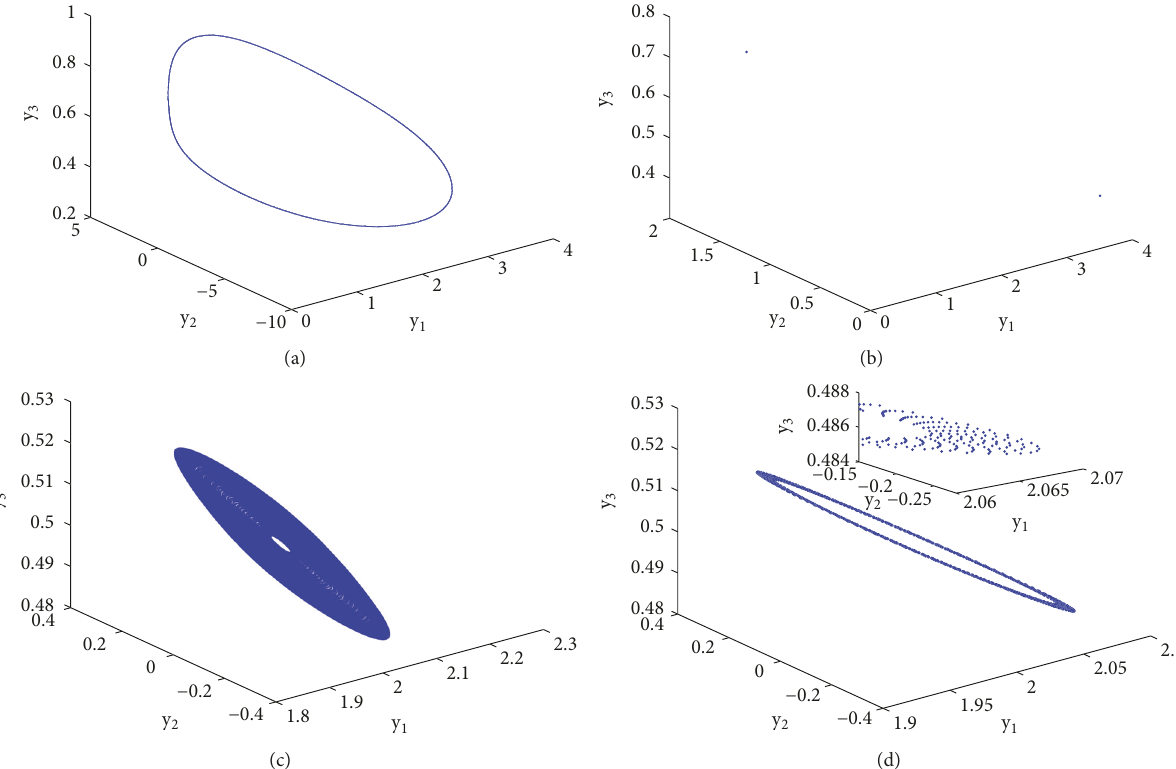
Figure 9: Phase portraits ((a), (c)) and Poincar´e sections ((b), (d)) for solutions in Figures 7(c) and 7(d); (a) and (b) for the solution in Figure 7(c); (c) and (d) for the one in Figure